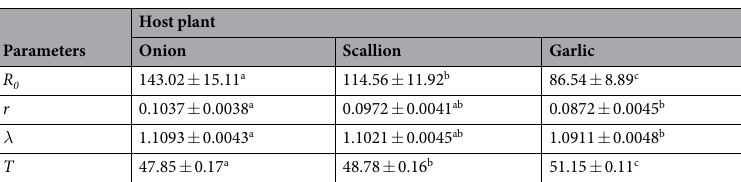
Table 3. Net reproductive rate ( R 0 ), the intrinsic rate of increase ( r ), finite rate of increase ( λ ), and generation time ( T ) of D. antiqua on different host plants of group reared method. The data of treatments were compared by using paired bootstrap test. Values are means ± standard errors; a,b,c Means in a row followed by different letters are significantly different at p < 0.05 by using paired bootstrap test (Table